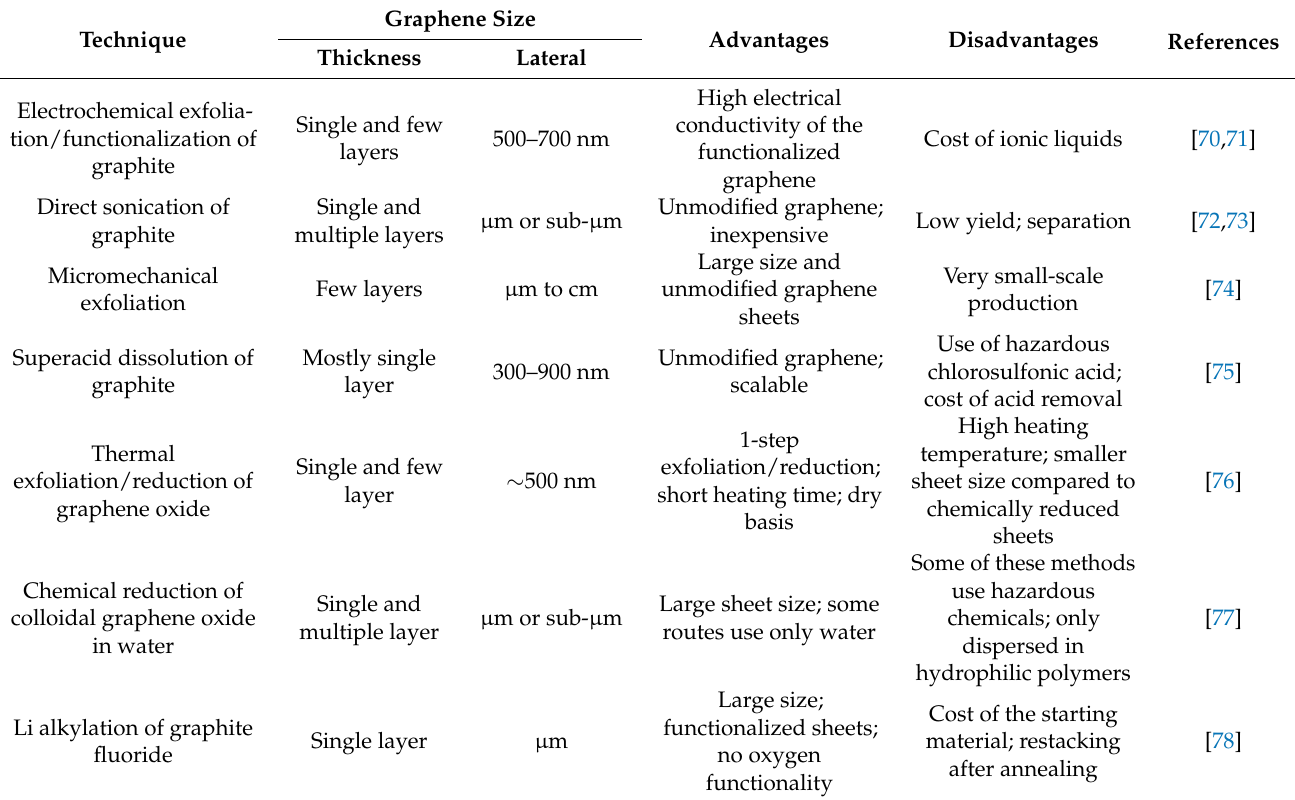
Table 2. Top-down techniques for producing graphene sheets. For each technique, the size of graphene sheets that can be obtained and the related advantages/disadvantages are reported.